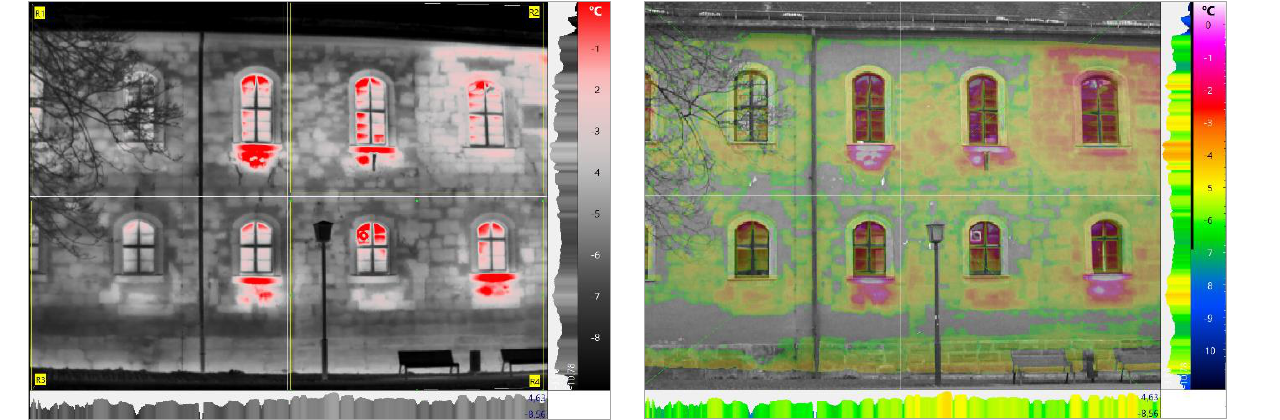
Figure 2: Greyscale and red marker visualisation. Focus on regions with highest temperature values.